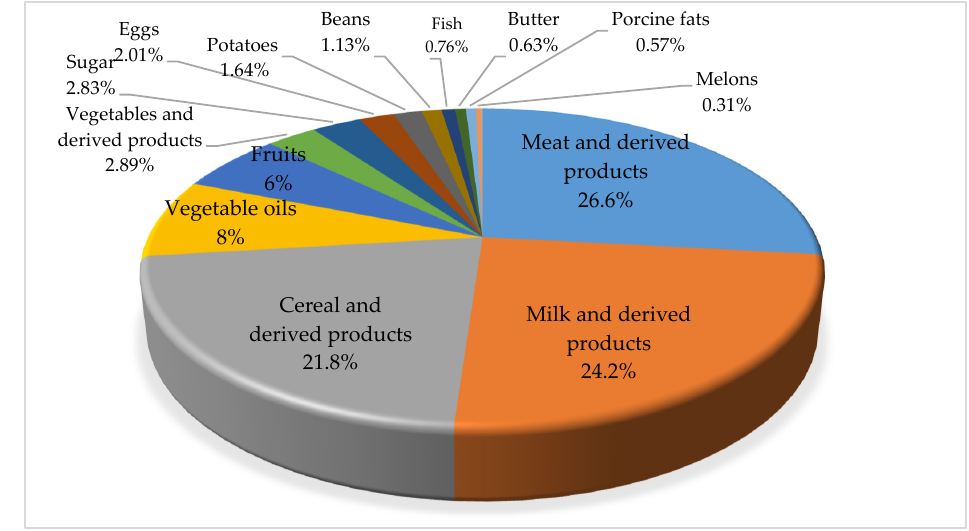
Figure 2. The proportion of the water footprint consumed by each type of food in Romania (%).